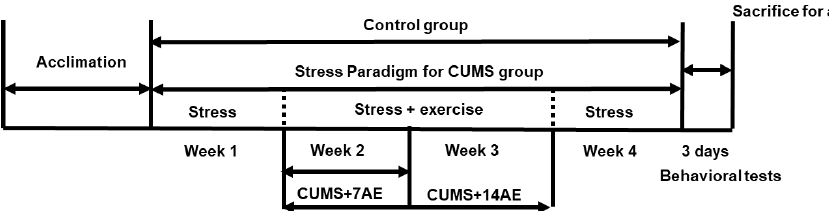
Figure 1. Experimental design. Open field test and forced swimming test were performed on after 4 weeks intervention. CUMS, chronic unpredictable mild stress.